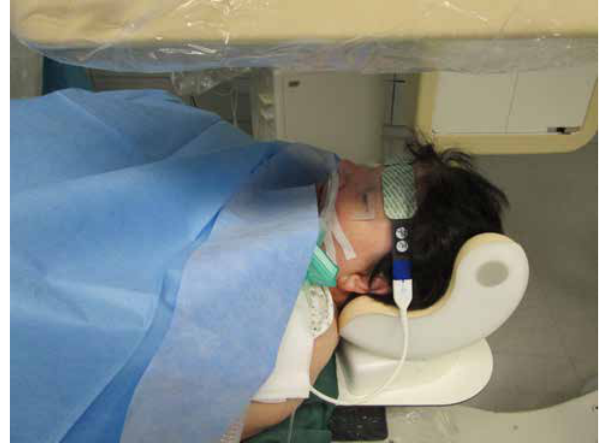
Figure 2: The frequently observed jam-packed anesthesia working place in radiology department; patient monitored with